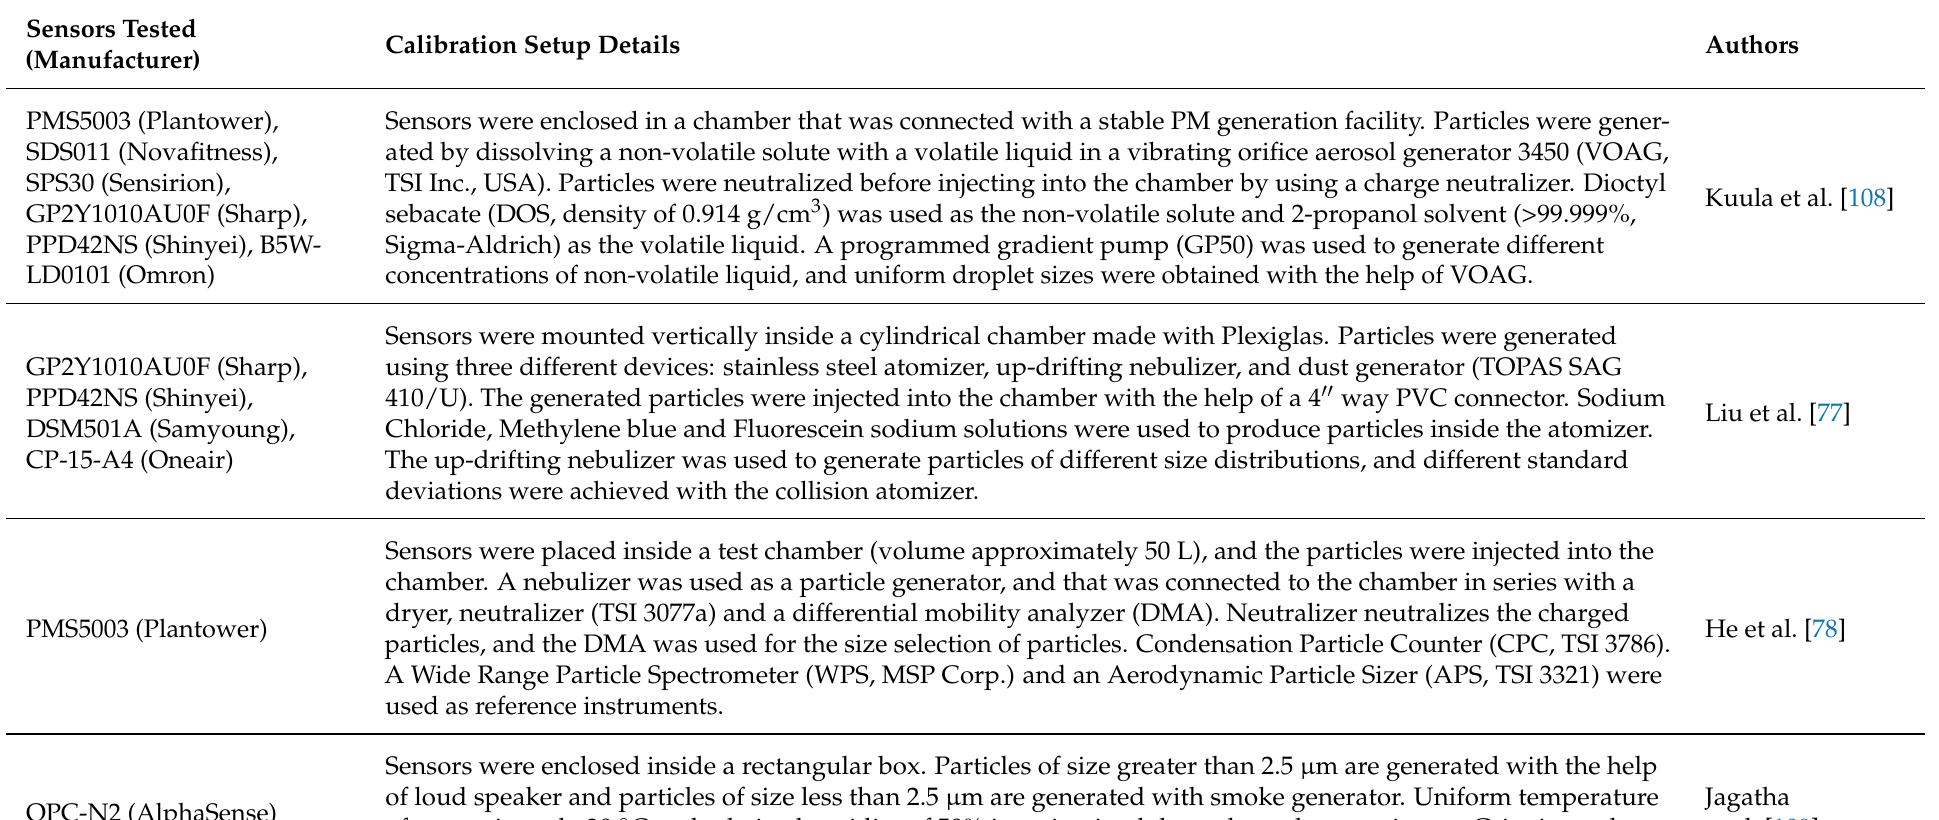
Table 5. Various laboratory calibration setups for particulate matter sensors based on the light scattering